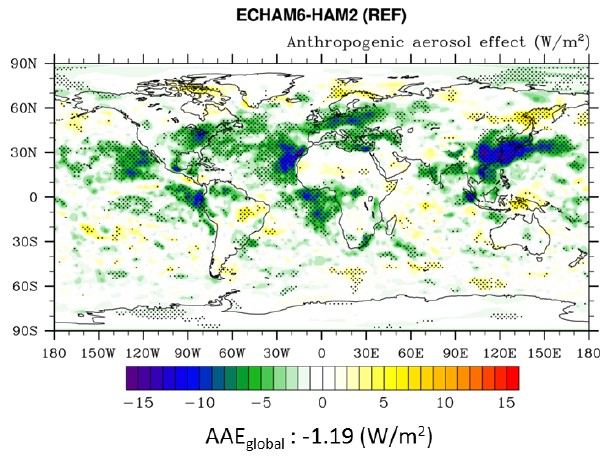
Figure 15. The total anthropogenic aerosol effect (AAE) is shown globally. The average value is shown below the